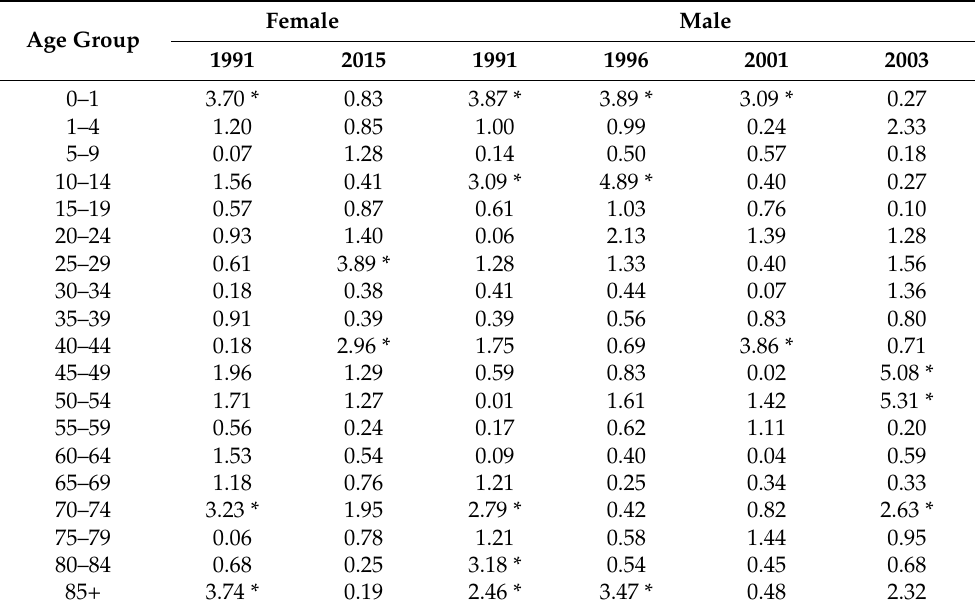
Table 4. Unconditional terms of the MTY decomposition for out-of-control